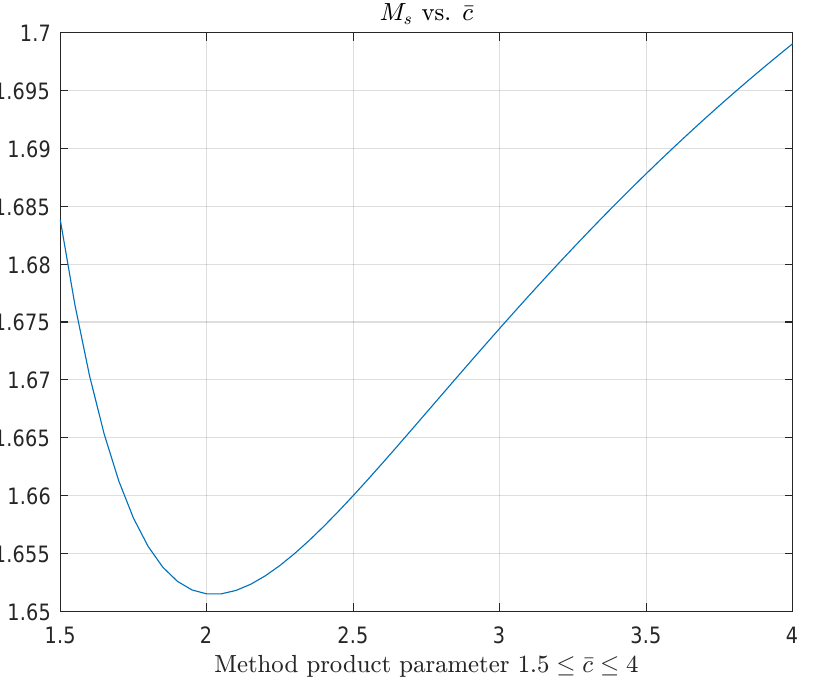
. The figure shows the s